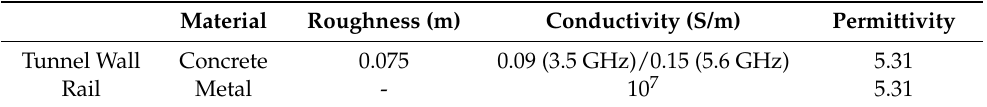
Table 2. Material parameters after calibration.